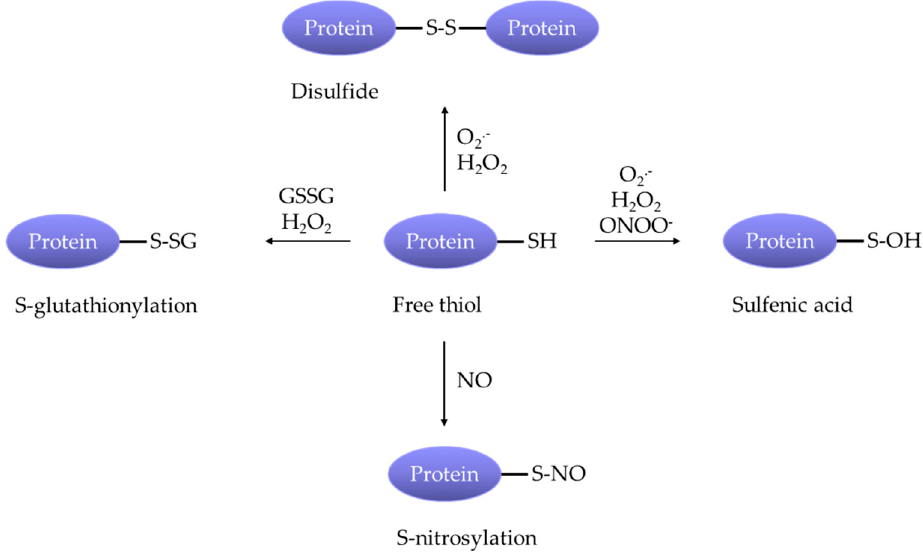
Figure 3. ROS facilitate pulmonary arterial constriction in pulmonary hypertension by make various posttranslational modifications at cysteine residues of ion channels and molecules.